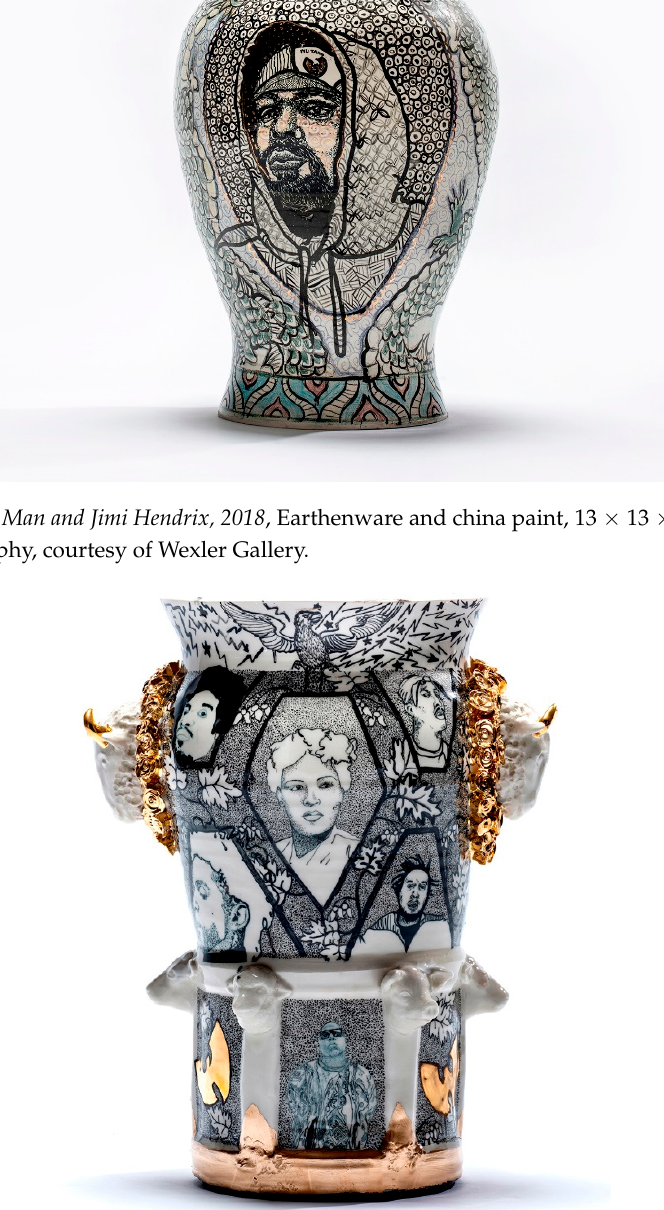
Figure 5. A Century of Black Music, 2018 , Porcelain and china paint, 13 × 9 × 16 in. Image by KeneK Photography, courtesy of Wexler Gallery.